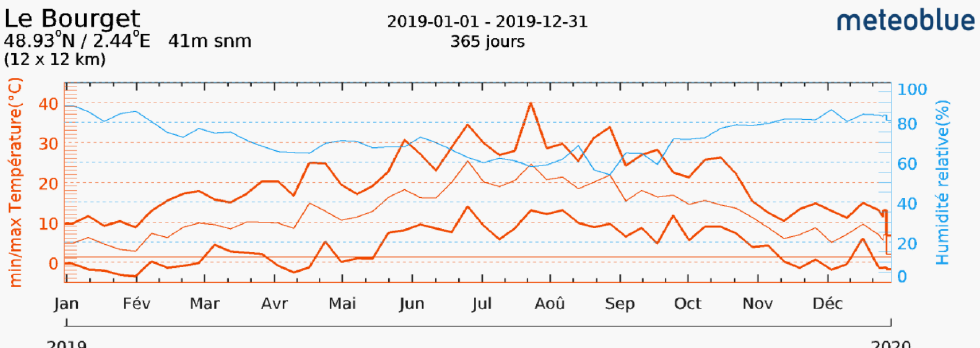
Figure 9. The weather data related to temperature and relative humidity for Le Bouget-du-Lac (year 2019) taken from www.meteoblue.com (accessed on 31 December